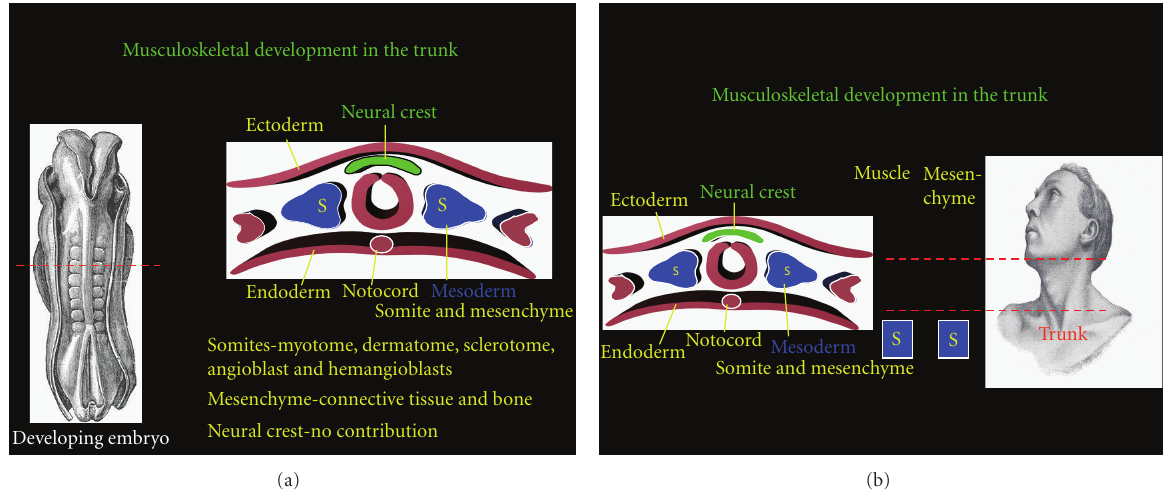
Figure 2: A cross-section of the developing trunk shows the formation of somites from the mesodermal cell population. Each somite forms a sclerotome, myotome, and dermatome. The trunk mesoderm will also form the mesenchyme (connective tissue, ligaments, and osseous attachment) of the trunk, but not the head or neck. Figure 2 reinforces the mesodermal origin of the trunk. Striated muscle arises from the myotome portion of somites, while connective tissue and bone are mesenchymal in origin. The transitional neck region di ff ers by having skeletal muscle derived from somites, while the mesenchymal component is formed from the neural crest.